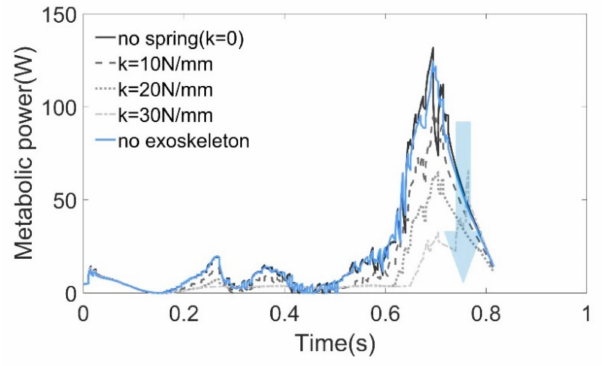
Figure 12. Metabolic cost of soleus under di ff erent sti ff ness